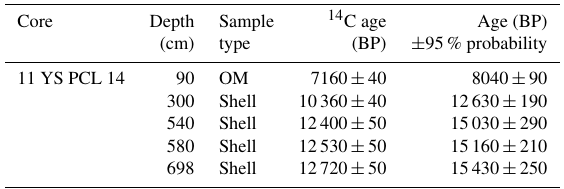
Table 1. Representative accelerator mass spectrometer radiocarbon age data for core PCL14 from Badejo et al. (2016). OM stands for organic